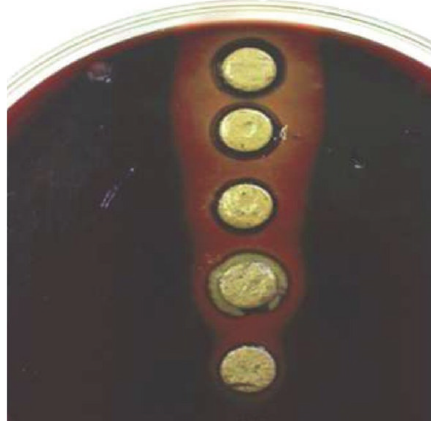
Figure 3: The effects of ethanolic extracts of Juglans regia bark against S. sanguis .